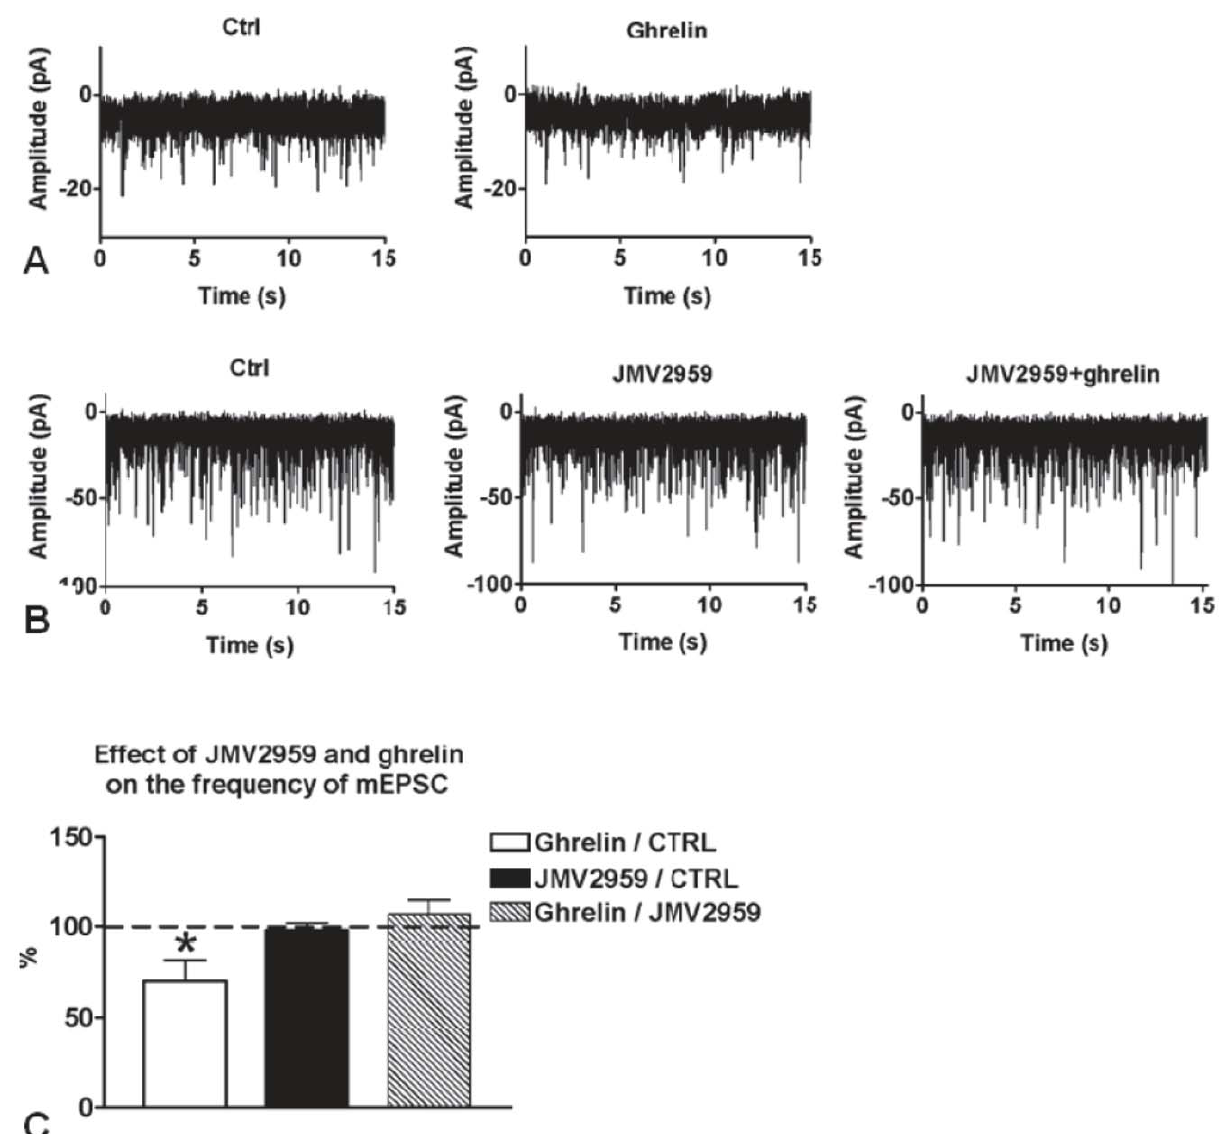
Figure 4. Whole-cell patch clamp recordings of mEPSCs in large pyramidal-like neurons of the lateral amygdala. A) Application of ghrelin (4 m M) in the extracellular solution decreased the frequency of the mEPSCs. B) Extracellular administration of the ghrelin receptor antagonist JMV2959 (10 m M), blocked this effect of ghrelin. C) Histogram shows the relative percentages of mEPSC frequencies. *P , 0.05.